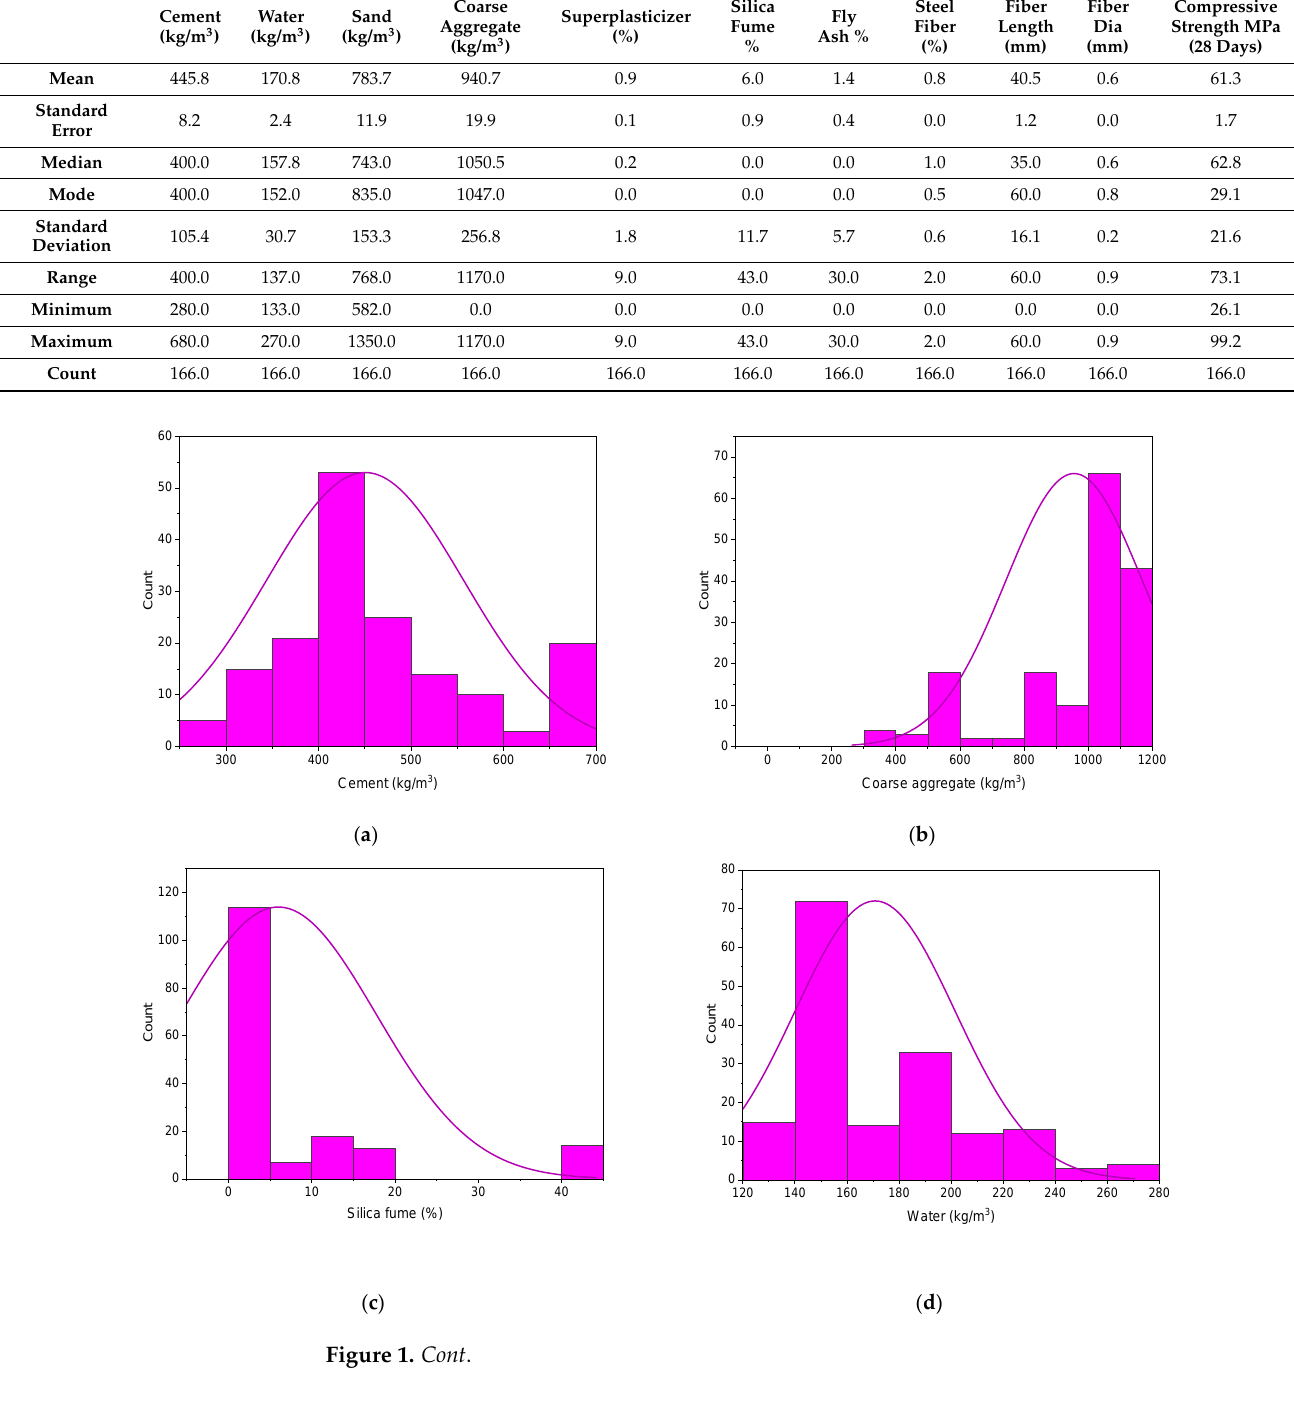
( h ) Figure 1. Relative frequency patterns of input and output factors: ( a ) cement; ( b ) coarse aggregate; ( c ) silica fume; ( d ) water; ( e ) superplasticizer; ( f ) volume fraction of steel hooked fibers; ( g ) sand; and ( h ) compressive strength.